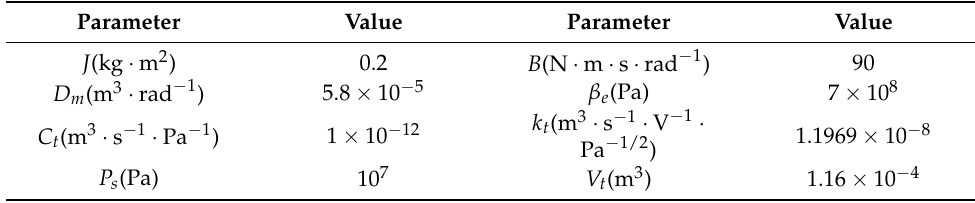
Table 1. The hydraulic system